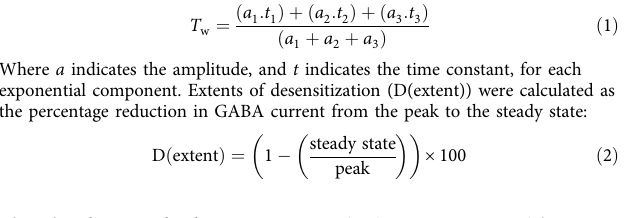
Fig. 8 GABA A R desensitization increases synaptic receptor numbers by phosphorylating γ 2 S327 and β 2 S410 . a Plots of synaptic current amplitude variance against current amplitude from peak-scaled non-stationary variance analysis of sIPSCs presented in Fig. 5 ( n = 13 and 10 cells, respectively). Data are shown for sIPSCs recorded from all GABA pretreated neurons (pink) and from controls (grey). b Single-channel current amplitudes ( I u ) are calculated for synaptic GABA A Rs for each treatment (two-tailed t -test: t (21) = − 1.17, p = 0.25). c Synaptic receptor numbers ( N c ) calculated for sIPSCs for each treatment (two-tailed t -test: t (21) = − 4.48, p = 0.00021). d Averaged sIPSC waveforms recorded from untransfected cells pretreated with either vehicle (grey) or GABA (pink), and cells expressing γ 2 S327A pretreated with GABA (purple), aligned to their rise phases. e Mean cumulative probability distributions of the sIPSC amplitudes and f Maximum rate of rise slopes of all sIPSCs recorded; n = 3470 events from 14 cells, 3808 events from 9 cells, 2266 events from 8 cells, and 4125 events from 6 cells, respectively, for each construct (mock, grey; + GABA, pink; γ 2 S327 + GABA, purple; β 2S 410 + GABA, blue). g Mean sIPSC amplitudes for the same conditions as in panel ( e ) and ( f ) (one-way ANOVA: F (3,33) = 29.20, p = 2.1 × 10 − 9 ; Tukey test (vehicle, S327A + GABA): p = 0.09; Tukey test (vehicle vs S410A): p = 0.12). h Mean 20 – 80% rise times for sIPSCs recorded under the indicated conditions (one-way ANOVA: F (3,34) = 1.32, p = 0.28). i Median IEI of the sIPSCs recorded from cells under the indicated conditions (one-way ANOVA: F (3,34) = 0.66, p = 0.58). j Immunoblots of lysates taken from HEK293 cells transiently transfected with the indicated constructs treated with either vehicle or GABA (1 mM) for 20 min prior to lysis. Blots were probed for phosphorylated (p) γ 2 S327 (top row), and for total γ 2 levels (bottom row). k Fold changes in the phosphorylation levels for γ 2 S327 in cells expressing the indicated constructs (control, black; α 1 V296L , red; γ 2L V262F , blue), after GABA 20 min treatment (one-sample t -test with a onefold change as the null hypothesis: t (11) = 2.35, p = 0.038; one-way ANOVA: F (2, 18) = 15.52, p = 0.00020; Tukey test (wt vs α 1 V296L ): p = 0.036; Tukey test (wt vs γ 2L V262F ): p = 0.042; n = 12, 9 and 11 lysates for WT, α 1 V296L and γ 2 V262F , respectively). Source data are provided as a Source data fi le for